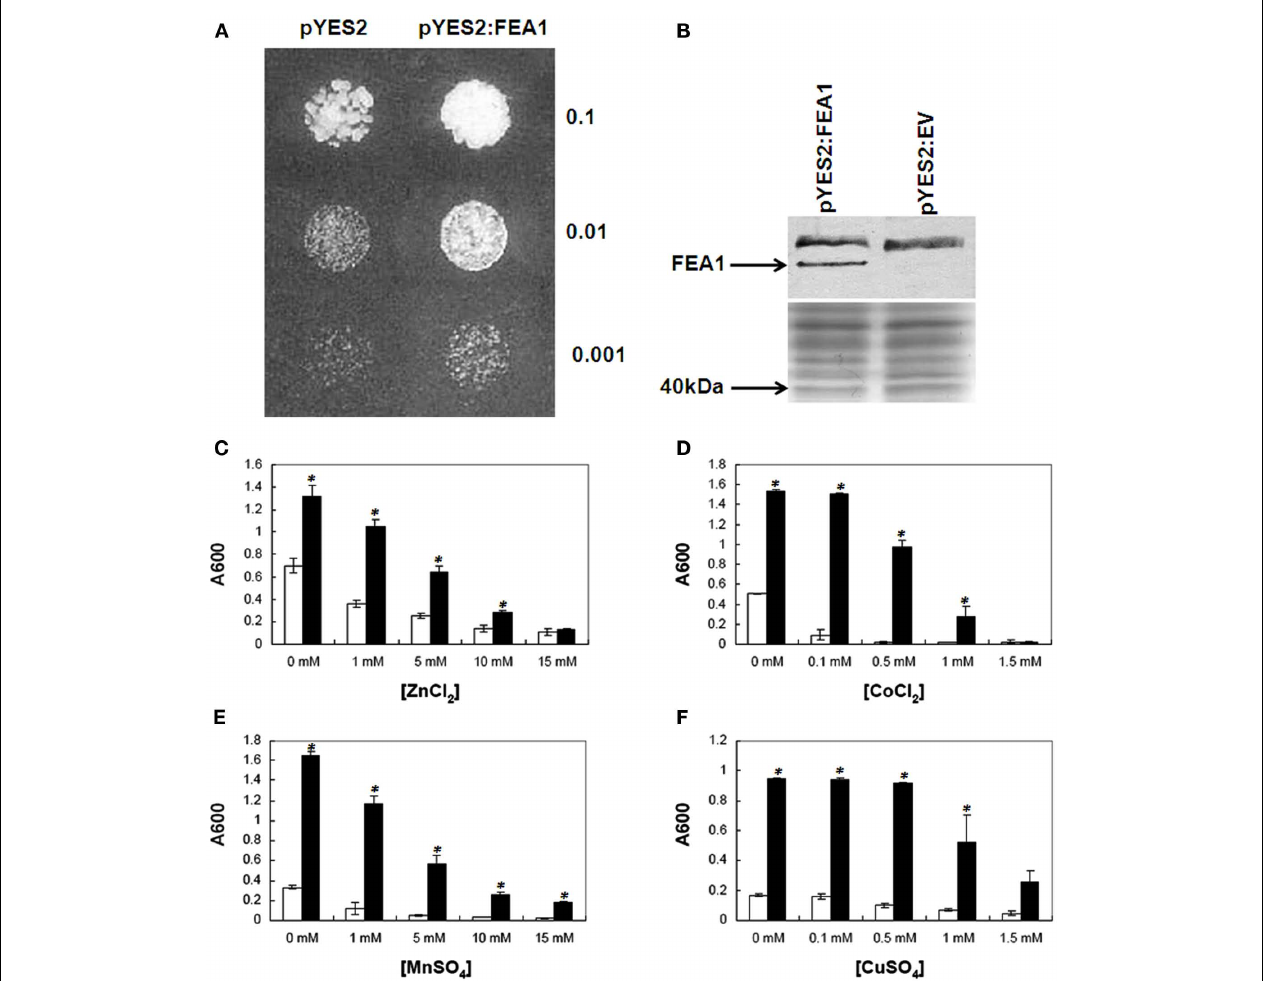
FIGURE 9 | FEA1 complements yeast Δ ftr1 mutant and is iron specific. (A) Cells transformed with either the pYES2: vector, or with pYES2: FEA1 were grown in liquid SC-URA galactose (pH 3.5) medium overnight. Cells equivalent to the indicated absorbance values at 600nm were spotted on SC-URA galactose (pH 3.5) plates. OD for the grown cultures was adjusted to 0.1 and diluted 10 and 100 times.The picture was taken after 72h incubation at 28C. (B) Western blot of Flag-tagged FEA1 immuno-detected with anti-FLAG M2-alkaline phosphatase antibody.The Coomassie-blue stained gel is shown below the western blot to show equal loading of the